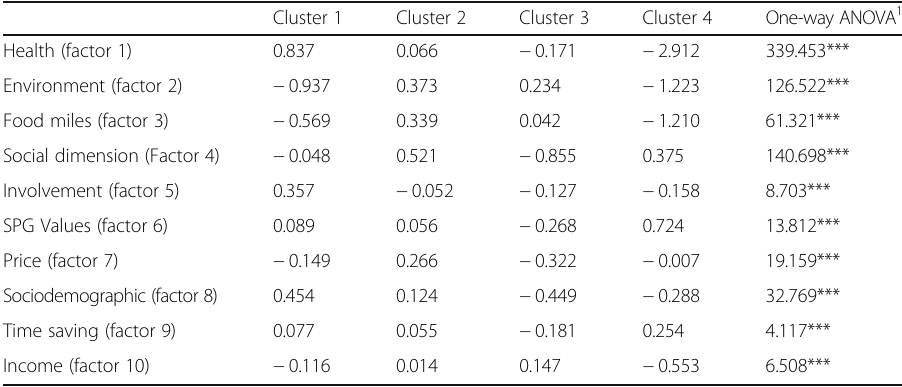
Table 6 Average of factor score for each cluster